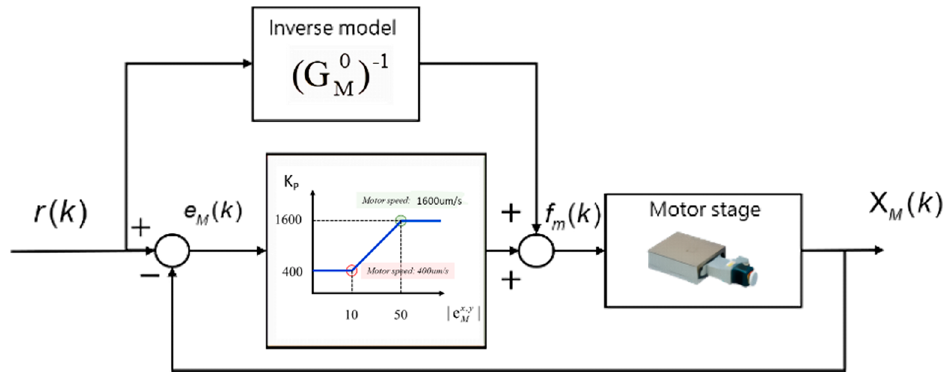
Figure 7. Gain-scheduling control with command feedforward for the motor stage.